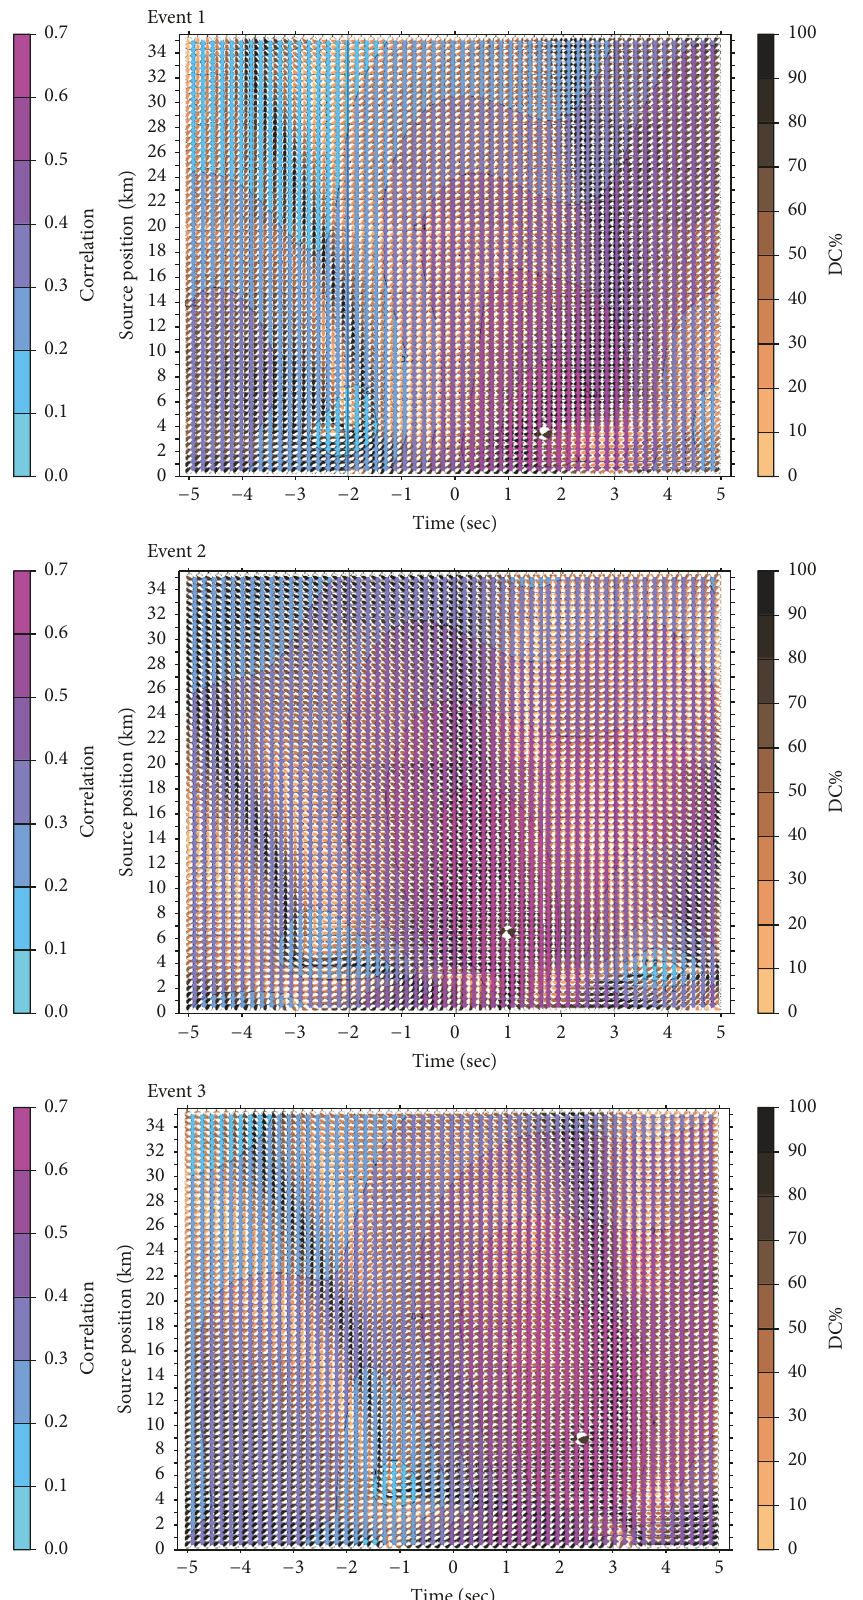
Figure 5: DC percentages and correlation coefficients in the corresponding focal mechanisms as a function of south depths and time shifts are drawn in beach ball colours and background contours, respectively. Largest beach balls are the best solutions related to Table